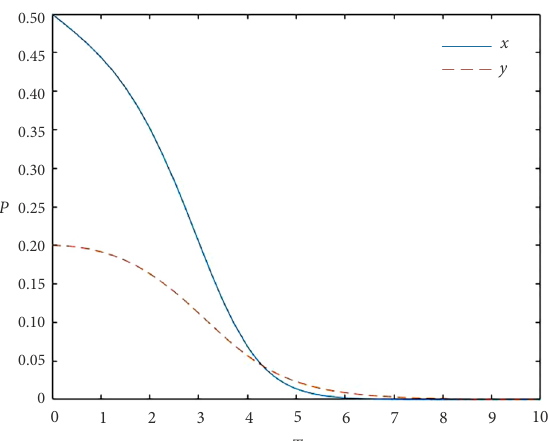
Figure 8. Probability trends for developers and customers with another data set ( H = 0, F = 0)